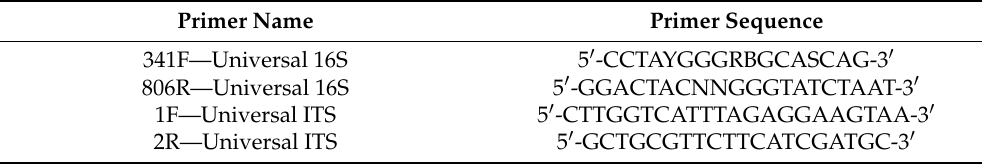
Table 2. Primers used for phylogenetic marker gene sequencing of bacteria and fungi.